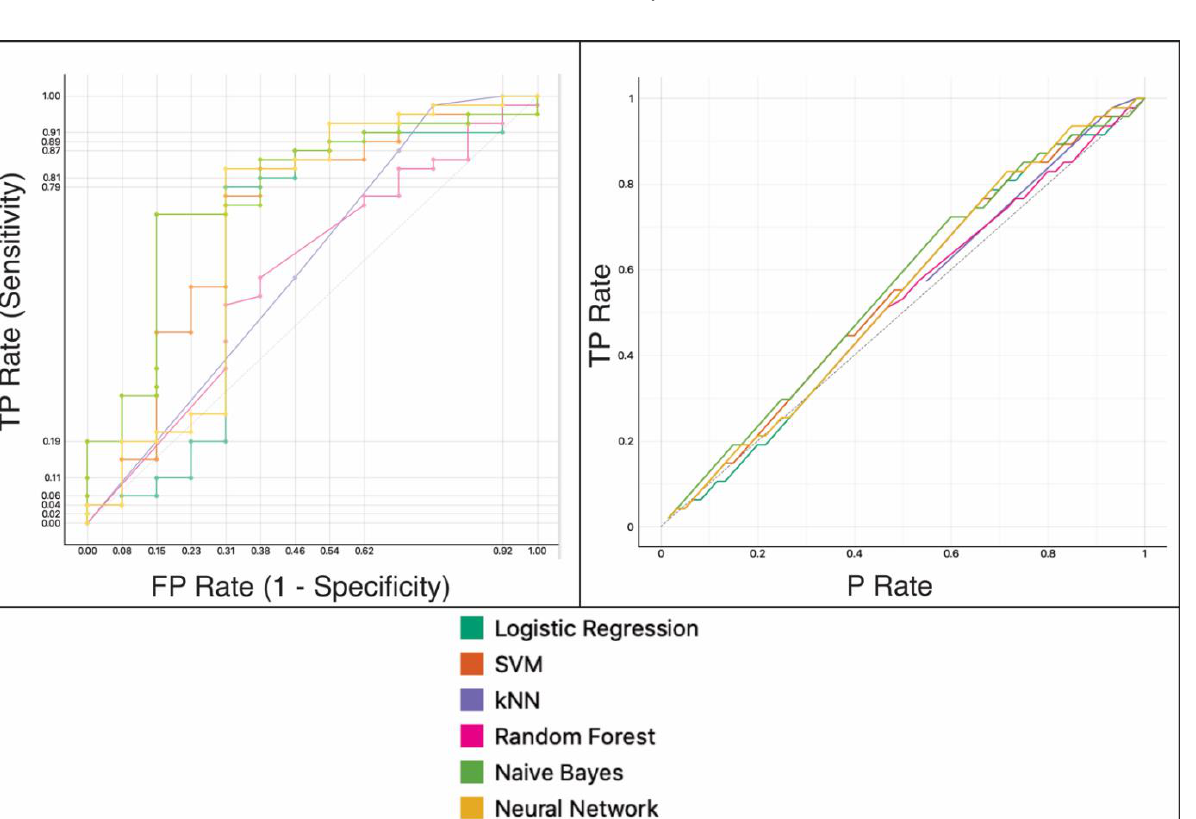
Table 4. Radiomic features selected by the variable hunting algorithm for Random Forest Survival prediction. Nº Feature